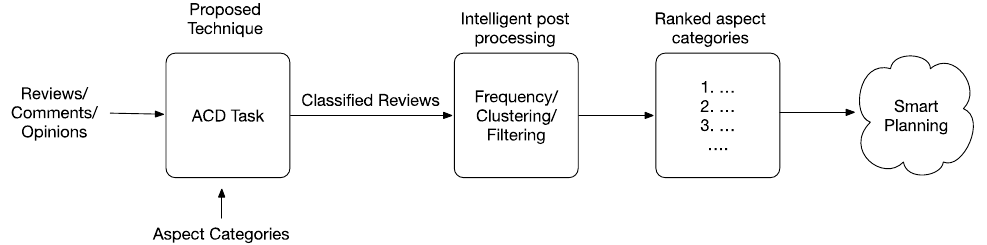
Figure 5. A simple work flow to show the use of ACD for making the planning process smart and efficient.